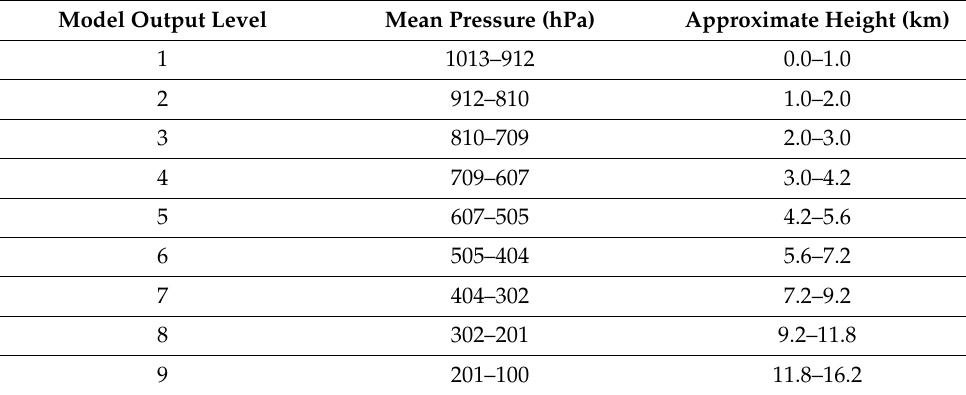
Table A1. Mean pressures and equivalent height for model output levels